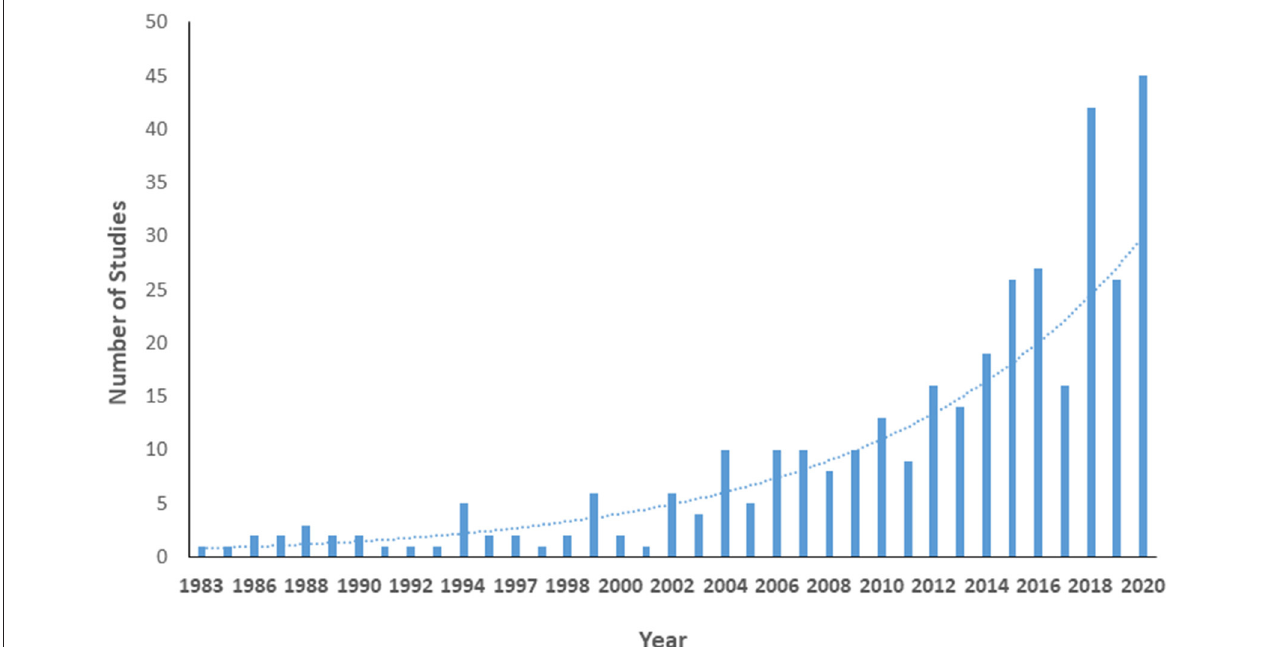
FIGURE 2 | Number of publications regarding women’s health in multiple sclerosis by